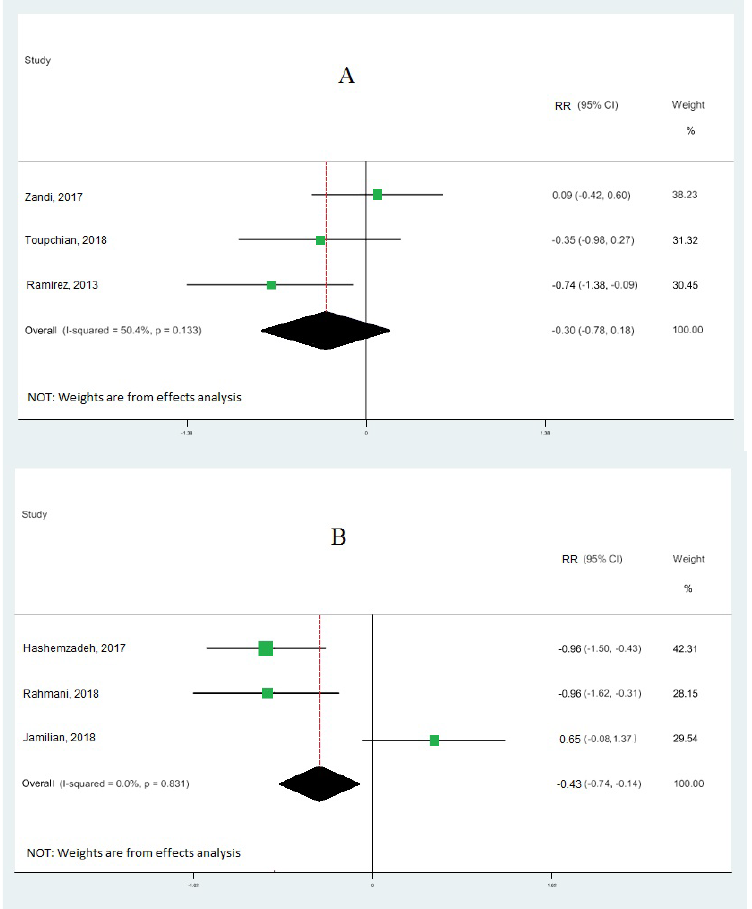
Figure 4. Forest plot of the highest vs. lowest meta-analysis of omega-3 effects on gene expression of inflammation: interleukin-6 ( A ) and interleukin-8 ( B ). RR and 95% CI are abbreviations of the relative risk and 95% confidence interval, respectively [19,33,34,36,38,39].